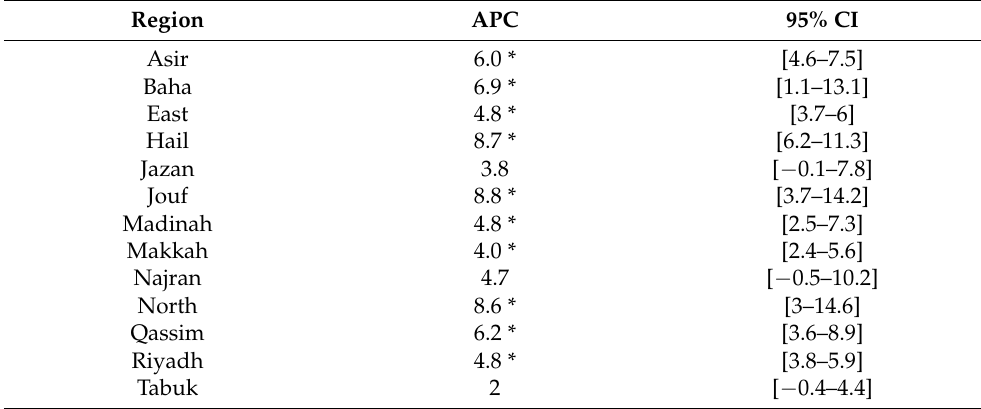
Table 4. Trends in Breast Cancer Incidence by Administrative Regions